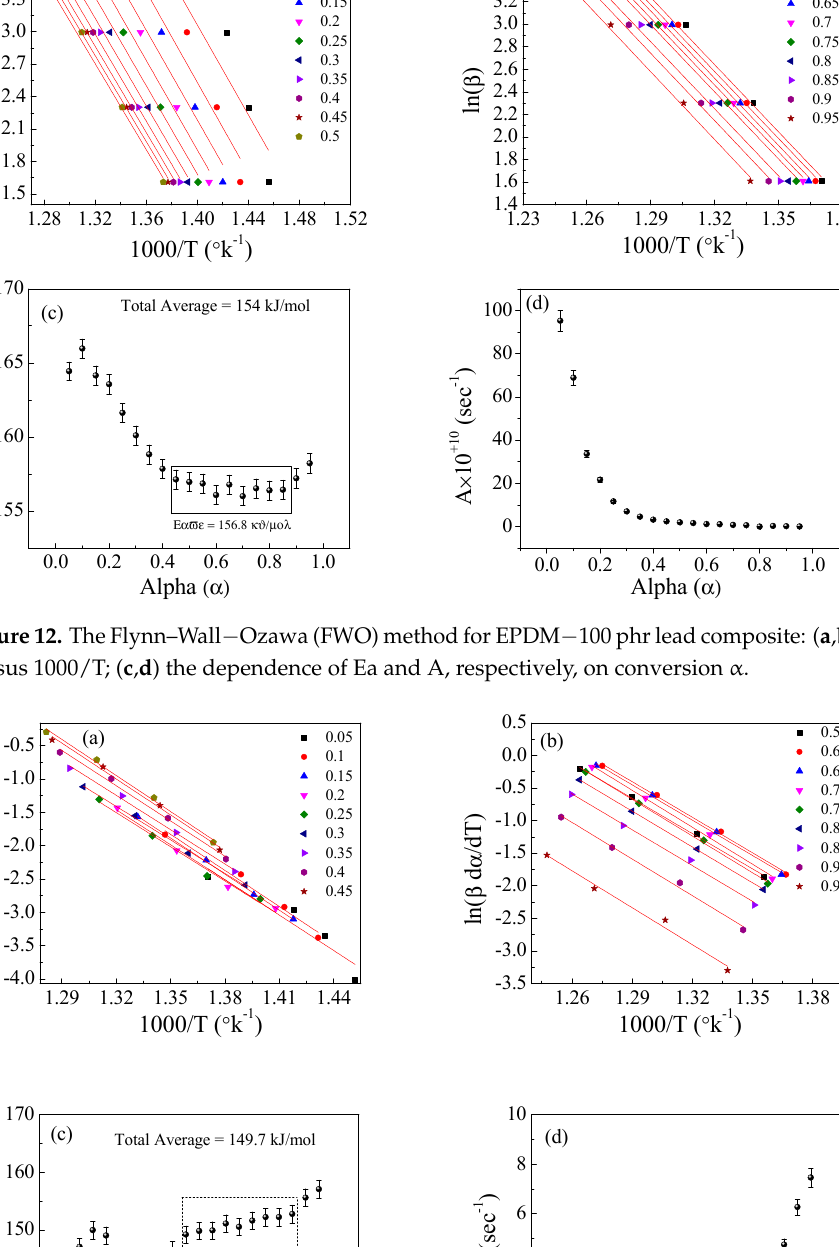
Figure 11. The Kissinger − Akahira − Sunose method for EPDM-100 phr lead composite: ( a , b ) ln( β /T2) versus temperature; ( c , d ) the dependence of E a and A, respectively, on conversion α .